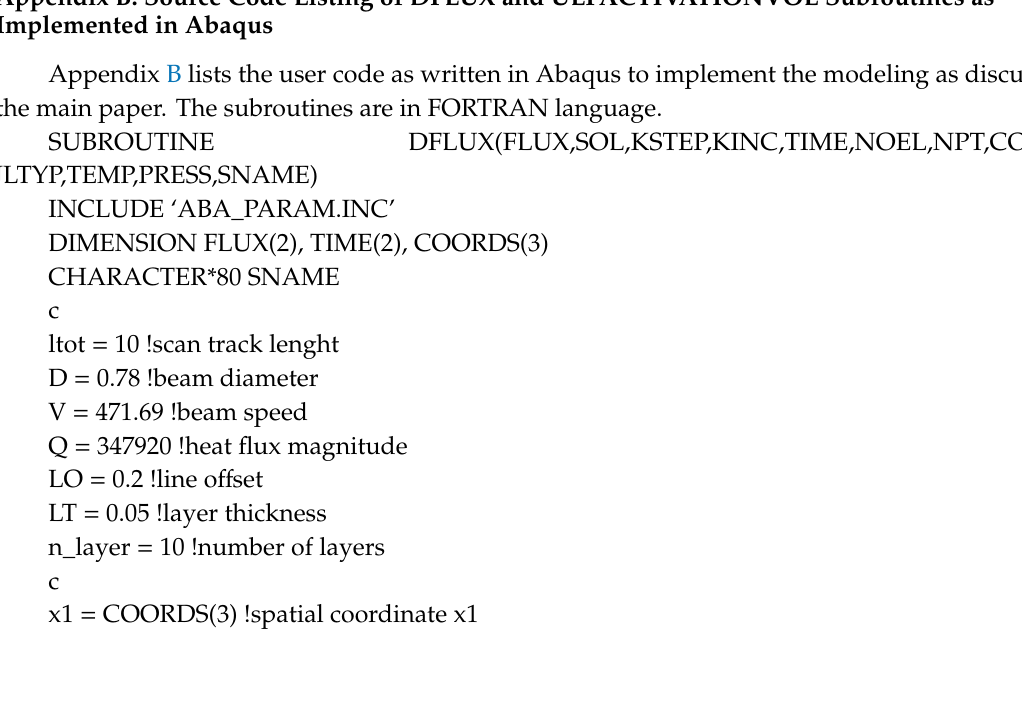
Figure A2. Numerical measurements of the surface roughness: ( a ) cross-section of the model that shows the ID state variable map ( b ) Numerical profile and its mean line for Ra calculation.